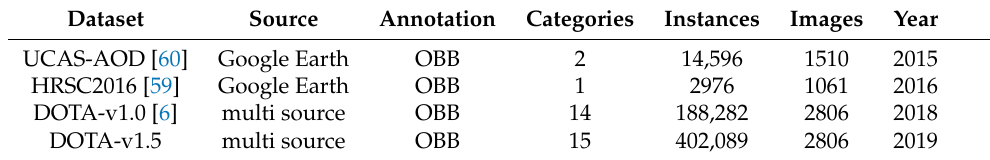
DOTA-v1.5 multi source OBB